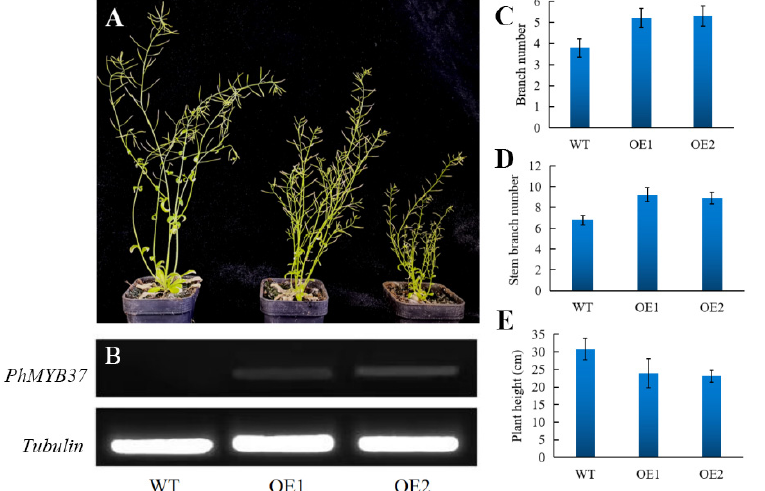
Figure 6. Analysis of the phenotype and gene expression in transgenic PhMYB37-overexpressing Arabidopsis plants. ( A ) Comparisons between the phenotypes of WT and transgenic plants that overexpress PhMYB37 . Different lines that overexpress PhMYB37 are represented by OE 1 and OE 2. ( B ) RT-PCR evaluated PhMYB37 expression levels. Tubulin detection served as the control. Twenty plantlets from each of three samples were averaged (±SE). ( C ) Each basal branch’s number is shown ( n = 15). ( D ) Each stem branch’s number is shown ( n = 15). ( E ) The primary stem height for each is displayed ( n = 15).